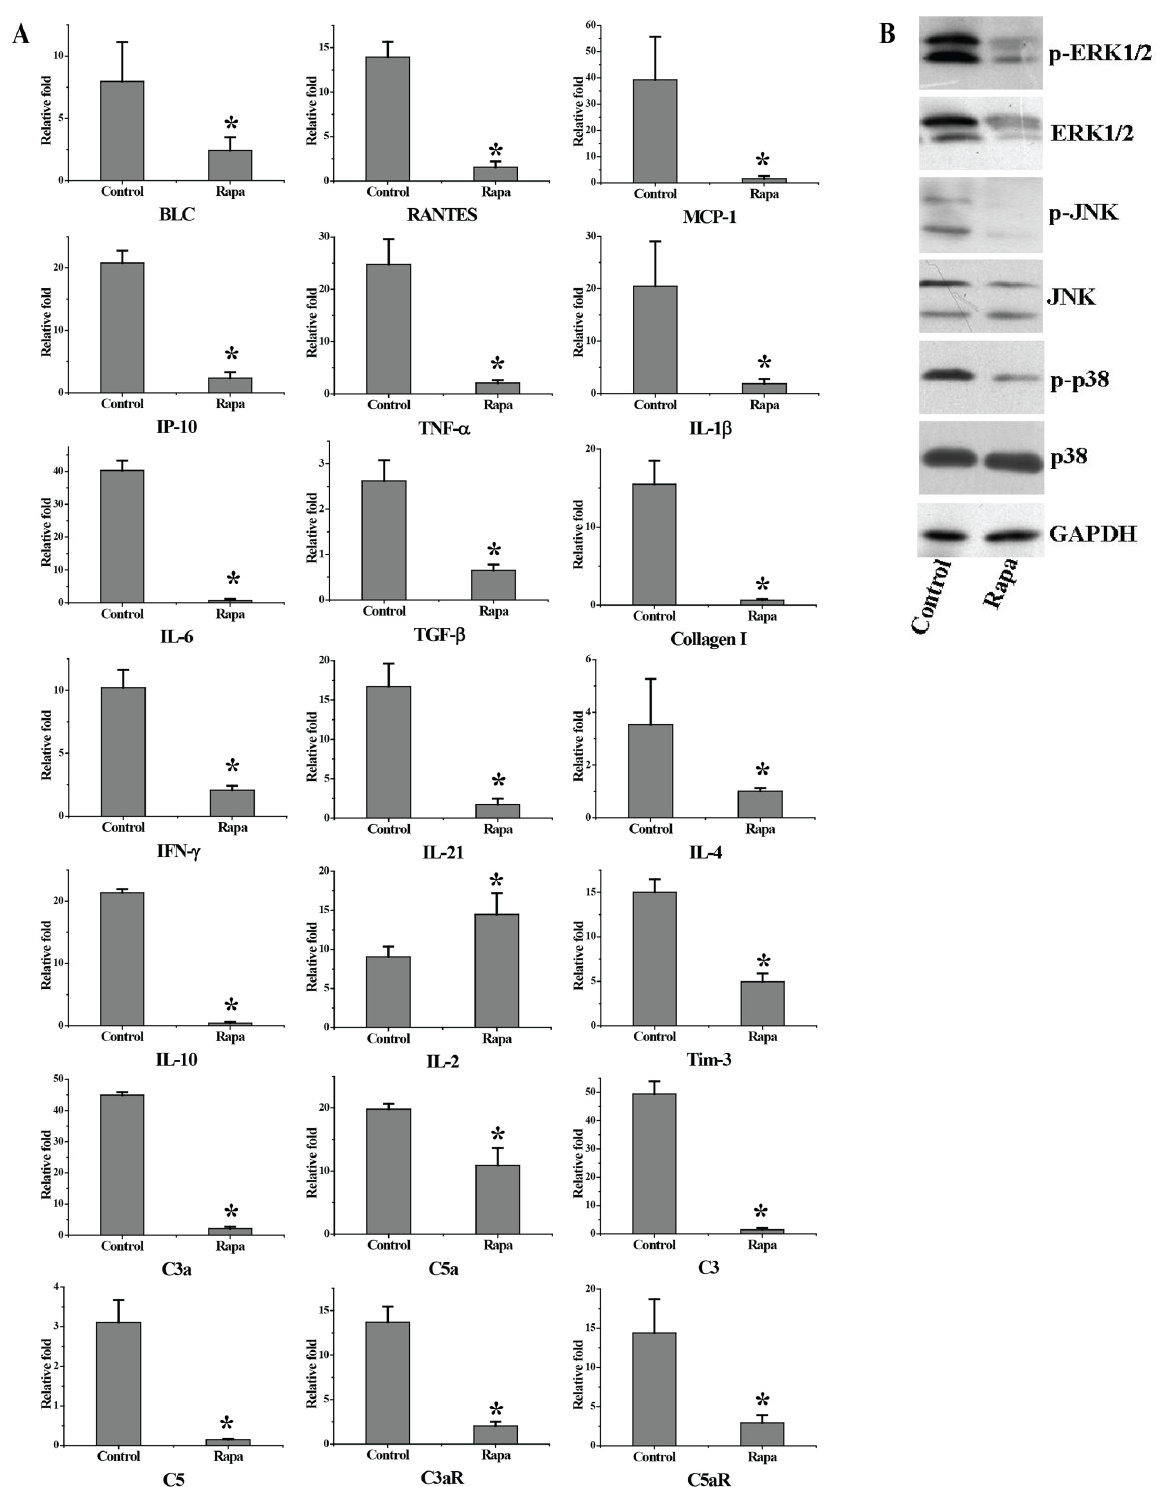
Figure 3. Rapamycin treatment downregulated the expression of the genes involved in pathogenesis of lupus nephritis and inflammation-related signaling pathways in the kidney. Kidneys were har- vested 12 weeks after transplantation. ( A ) The renal mRNA levels of pathogenic factors related to lupus nephritis were determined by quantitative real-time PCR, ( n ≥ 6) * p < 0.05. ( B ) Western blot analysis of ERK1/2 JNK p38 and GAPDH from kidney tissue. Representative date are shown from three independent